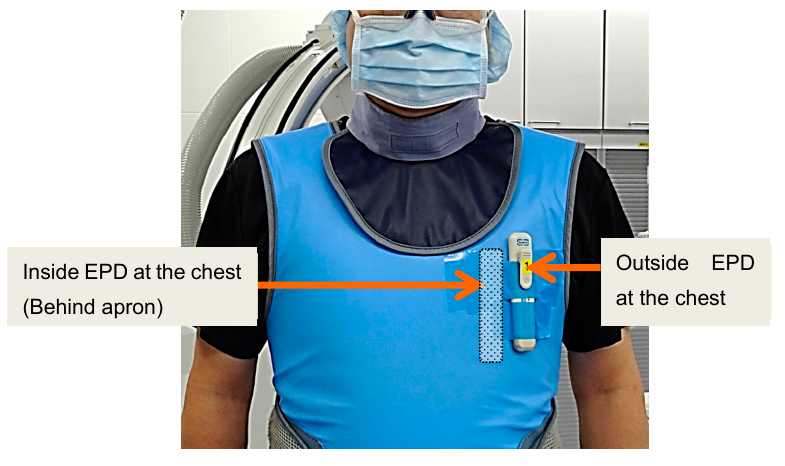
Figure 1. The position of the two electric personal dosimeters (EPDs) worn on the physician’s protective apron in a clinical setting. The radiation shielding effects (%) of the protective aprons were also determined as follows: Radiation shielding effects (%) = (1 − inside dose/outside dose) × 100.